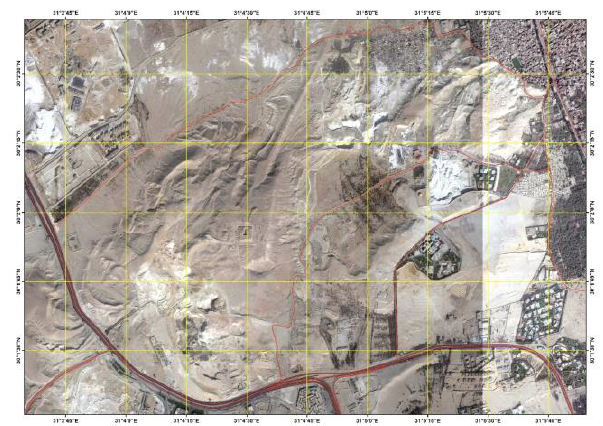
Figure 1a: Geologic map of Abu-Roash area (after Abu Khadra et al, 2005).